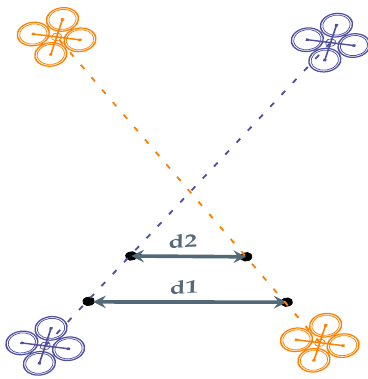
Figure 7. Example of two aircraft with converging trajectories.